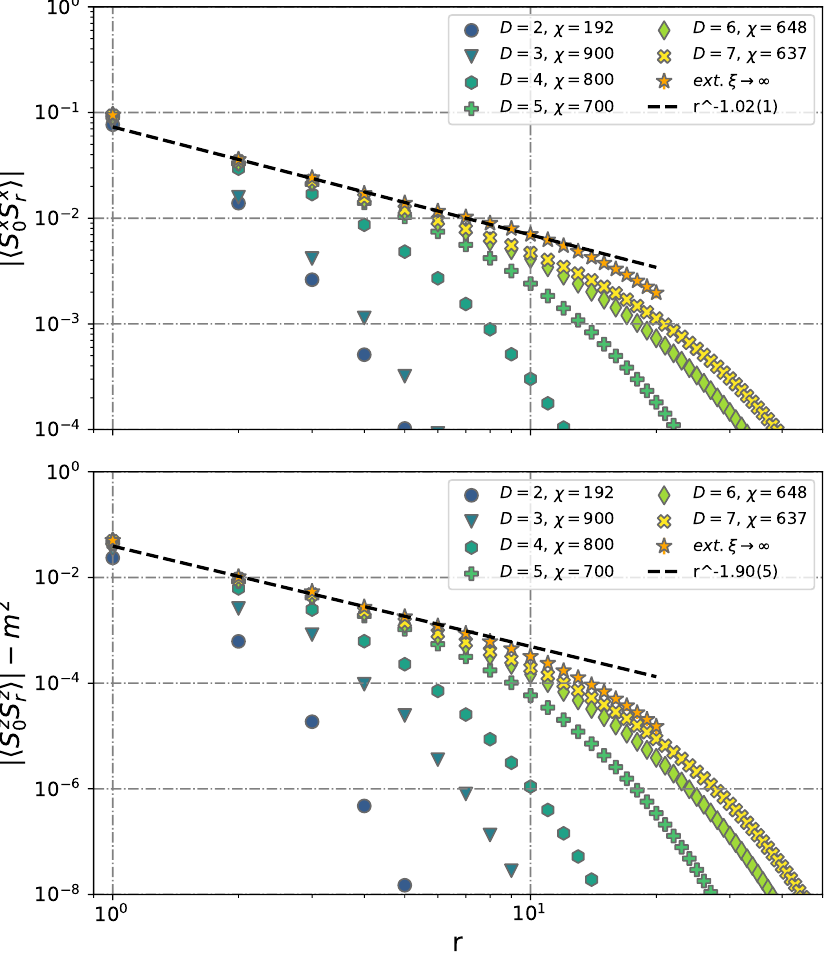
= 0 are shown in the 2